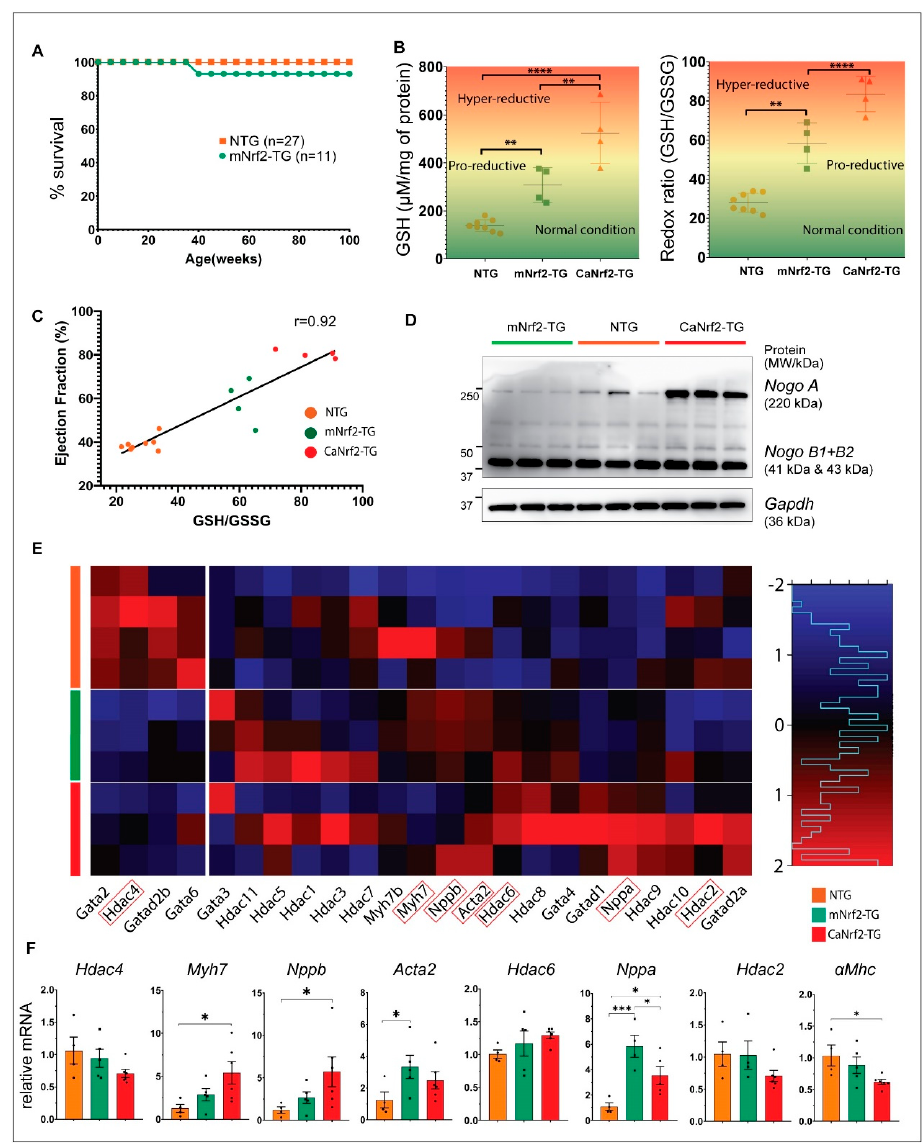
Figure 4. Survival, redox state, cardiac function, and remodelling in mNrf2 and CaNrf2 mice. ( A ) Kaplan–Meier survival analysis expressed in terms of percentage survival. ( B ) Redox scores of mNrf2-TG and CaNrf2 mice compared to controls, mapped on a gradient scale. ( C ) Redox state and cardiac function of NTG (orange) and mNrf2-TG (green) and CaNrf2 (red) hearts expressed in terms of ejection fraction (%) versus mean redox state (GSH/GSSG). EF and GSH data were paired within experimental groups. ( D ) Expression of Nogo A and Nogo B detected using Western blot from heart lysates. Membrane was stripped and reprobed for Gapdh. ( E ) RNAseq mRNA expression heatmap of common cellular hypertrophy indicators in normal, pro-reductive and hyper-reductive hearts. Log normalized data of genes scaled using R scale function shows distinctive changes between control, mNrf2-TG and CaNrf2. Column break for 4 markers (genes) that are downregulated in transgenic models together. Row breaks for groups with n = 3/4. ( F ) qPCR quantification of mRNA expression for cellular hypertrophy markers normalized to Gapdh. Error bars represent SEM.* p -value < 0.05, ** p -value < 0.01, *** p -value < 0.001, **** p -value <